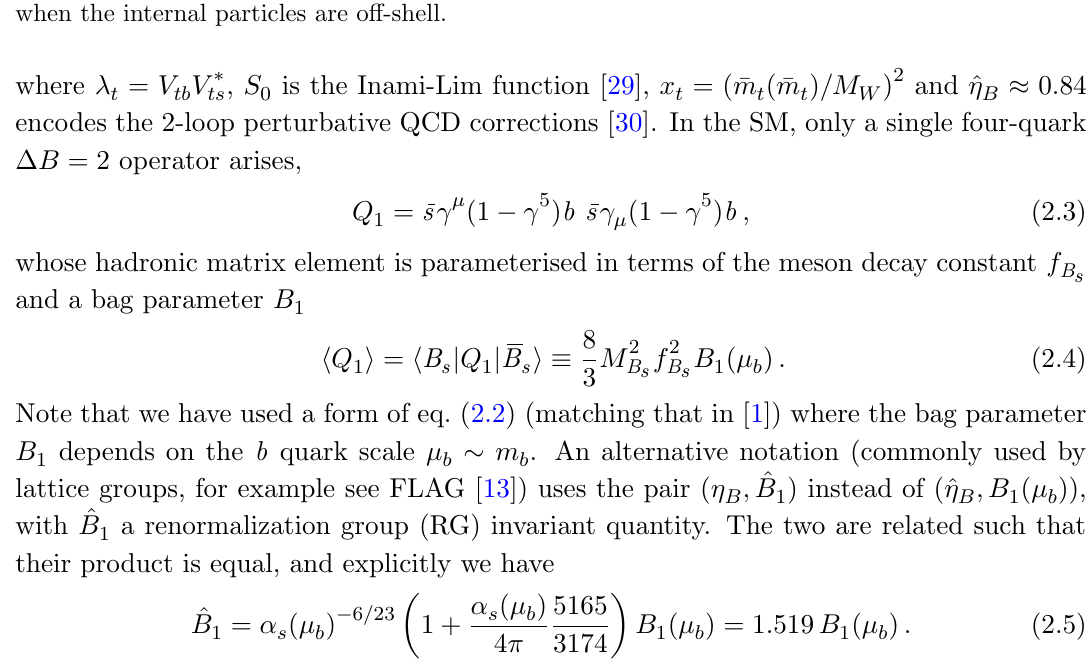
- B mixing process in the SM. M s s s